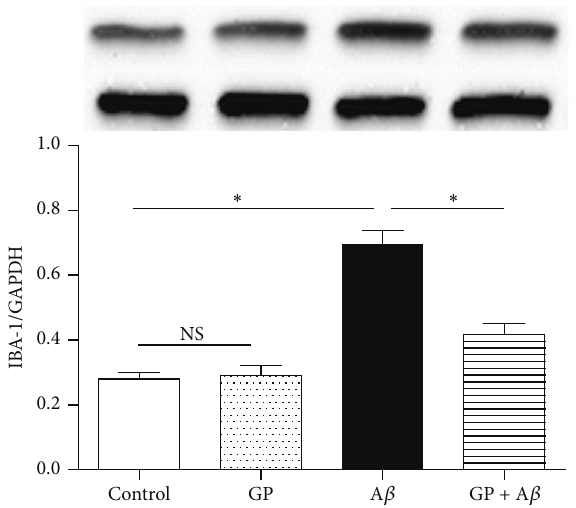
Figure 4: GP partially abolished A 𝛽 -induced effects on IBA-1 protein expression. The N9 microglial cells were divided into four groups, including control: cells cultured in normal medium; GP: cells cultured in the medium containing 50 𝜇 g/mL GP; A 𝛽 : cells cultured in the medium containing 10 𝜇 M A 𝛽 ; GP + A 𝛽 : cells cultured in the medium containing 50 𝜇 g/mL GP and 10 𝜇 M A 𝛽 . After 24-h incubation, western blot ( 𝑛 = 4 ) was taken to measure the IBA-1 expression. Data are means ± SD, ∗ : 𝑃 < 0.05 , NS: no